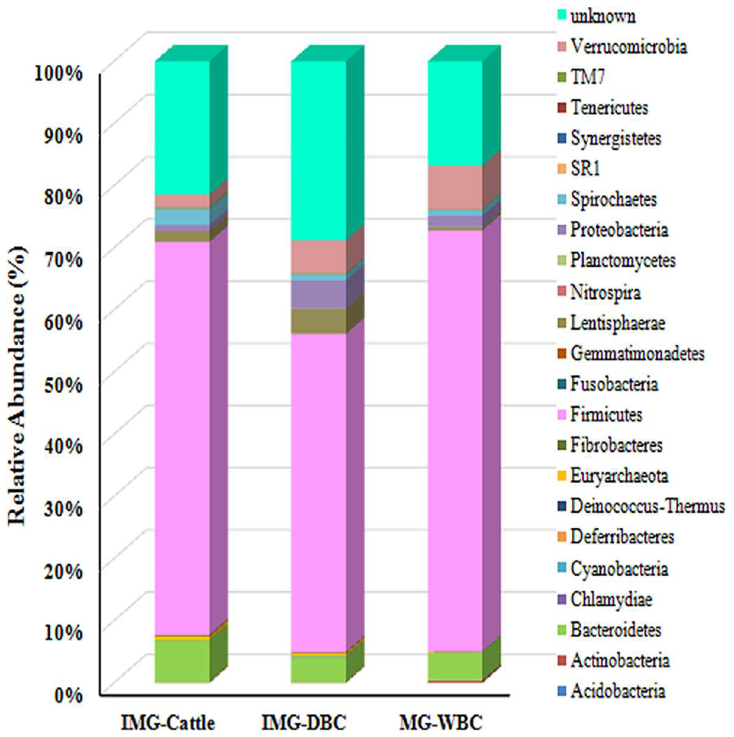
Fig 1. Bacterial composition in feces from different population groups (relative read abundance by phylum). Sequences that could not be classifiedinto any known group were assignedas ‘Unknownbacteria’.